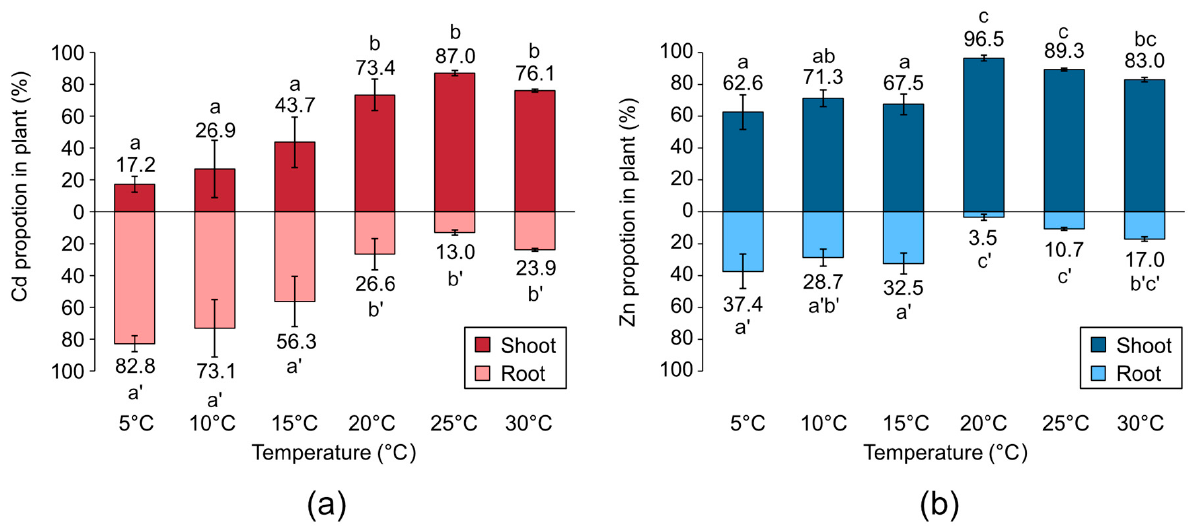
Figure 3. ( a ) Cd and ( b ) Zn distributions in the plant at different temperatures. The same letters indicate no significant differences between samples according to the Tukey–Kramer test ( p < 0.05).